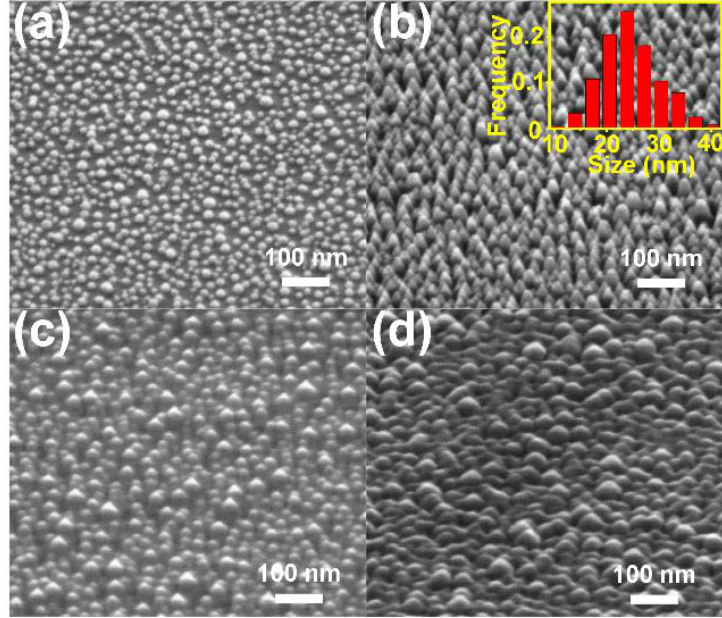
Figure 3. SEM images of sample with gold masks ( a ) before and ( b – d ) after inductively coupled plasma (ICP) etching for 30, 60, and 90 s, respectively. Inset: size distribution histogram of nanocones in ( b ).